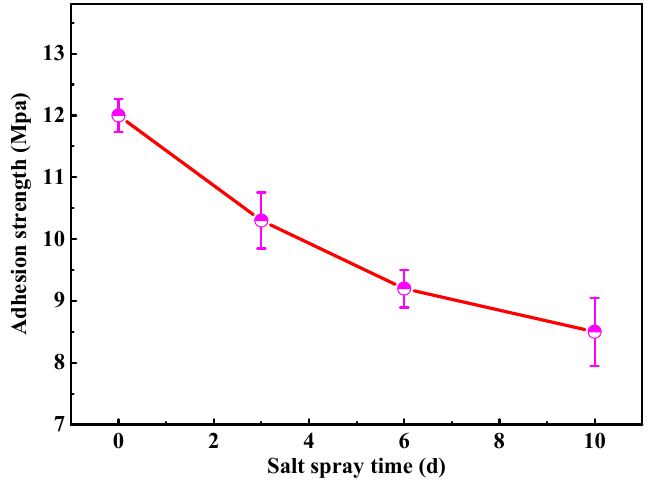
Figure 4. The adhesion strength of the modified waterborne polyurethane coating.